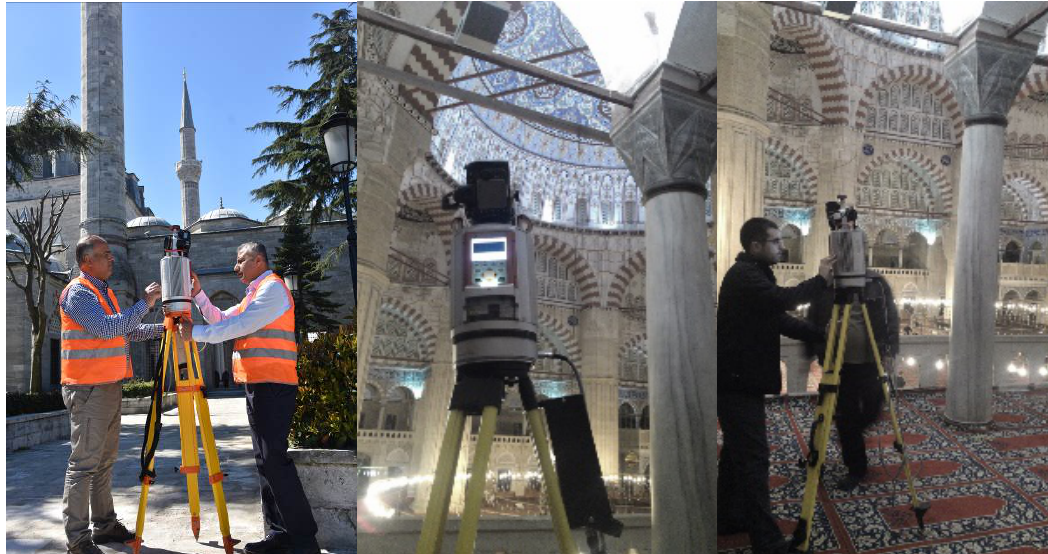
Figure 2. Data acquisition with the terrestrial laser scanning system Riegl VZ-400 on top of a minaret (left) and inside the mosque (centre and